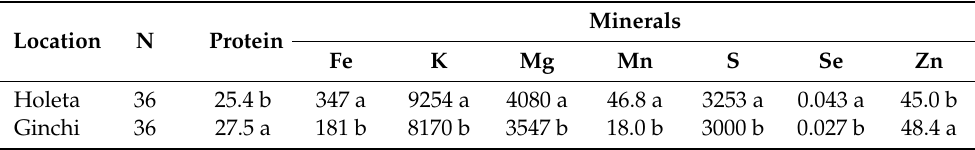
Table 4. Mean values of the seed protein concentration (%) and of mineral content ( µ g g − 1 ) for those minerals showing a significant difference between the two experimental